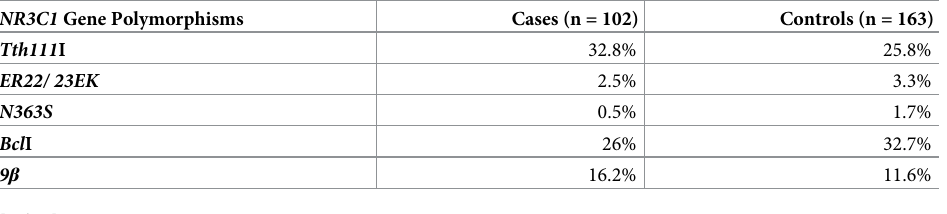
Table 1. Minor allelic frequencies (MAF) of the studied SNPs: Tth111 I (rs10052957), ER22 / 23EK (rs6189, rs6190), N363S (rs56149945), Bcl I (rs41423247) and 9 β (rs6198) in 102 CAH-subjects and 163 healthy